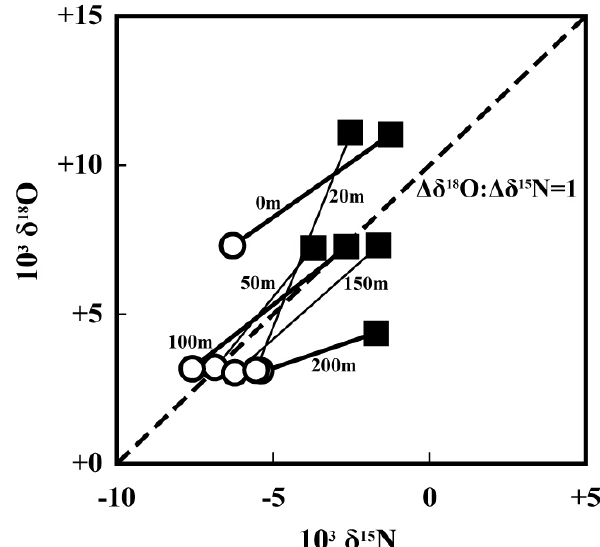
Fig. 5. Temporal changes in the δ 18 O and δ 15 N values of nitrate at each depth during the period between observations. The symbols are the same as those in Fig.